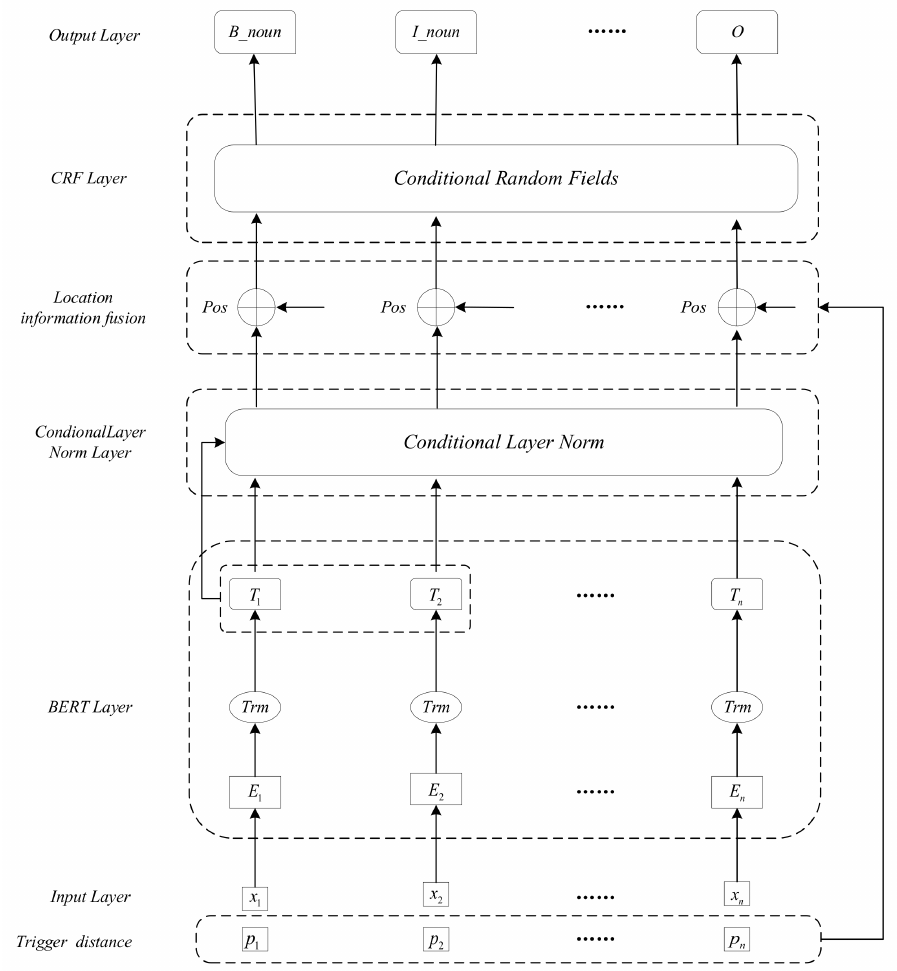
Figure 5. Structure of arguments recognition